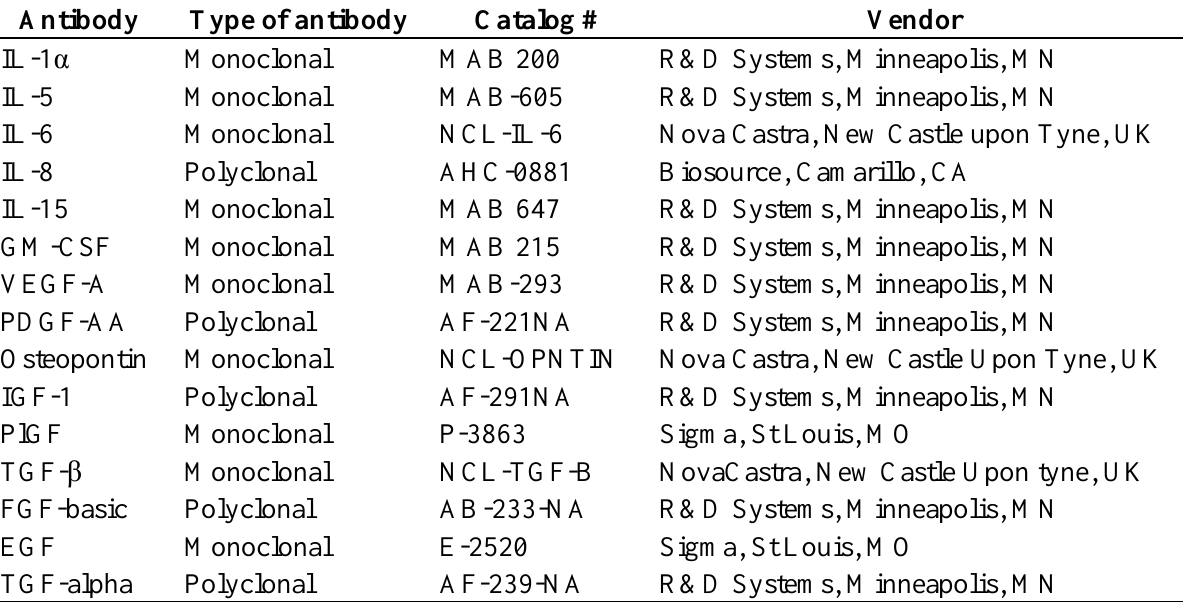
Table 7. Details of the antibodies used for IHC of cytokines and growth